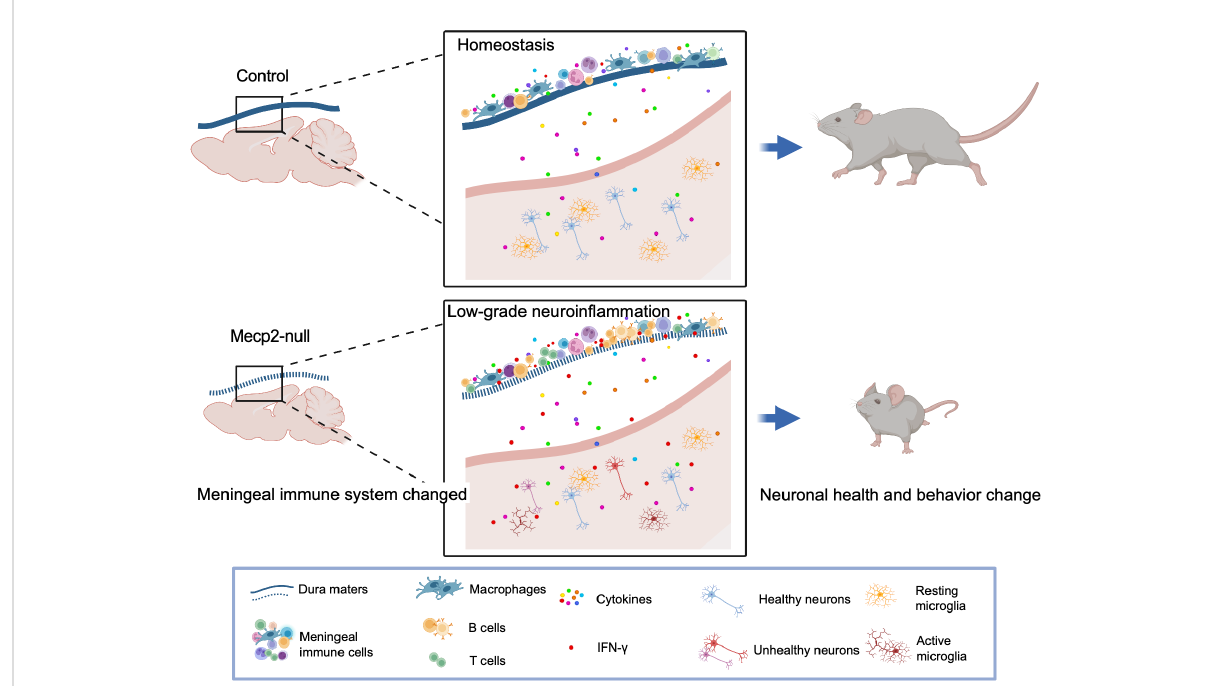
FIGURE 7 Model for the mechanisms of meningeal immunity in Mecp2 -null mouse. Illustration of the hypothesis for the mechanisms of meningeal immunity with the progression of disease in Mecp2 -null mice (created with Biorender.com). Meninges surrounding the brain have functional lymphatic system and abundant of immune cells which play important roles for maintaining the central nervous system in health. Mecp2 -null mice show de fi ciency of meningeal lymphatics and activity status altered of immune cells in dura mater. The non-infectious in fl ammatory response can spread to the CNS parenchyma, causing low-grade neuroin fl ammation, and further impairing neuronal health and behavior